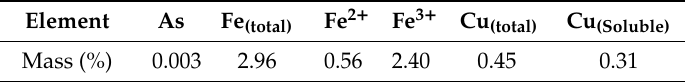
Table 2. Chemical composition of the initial sample.